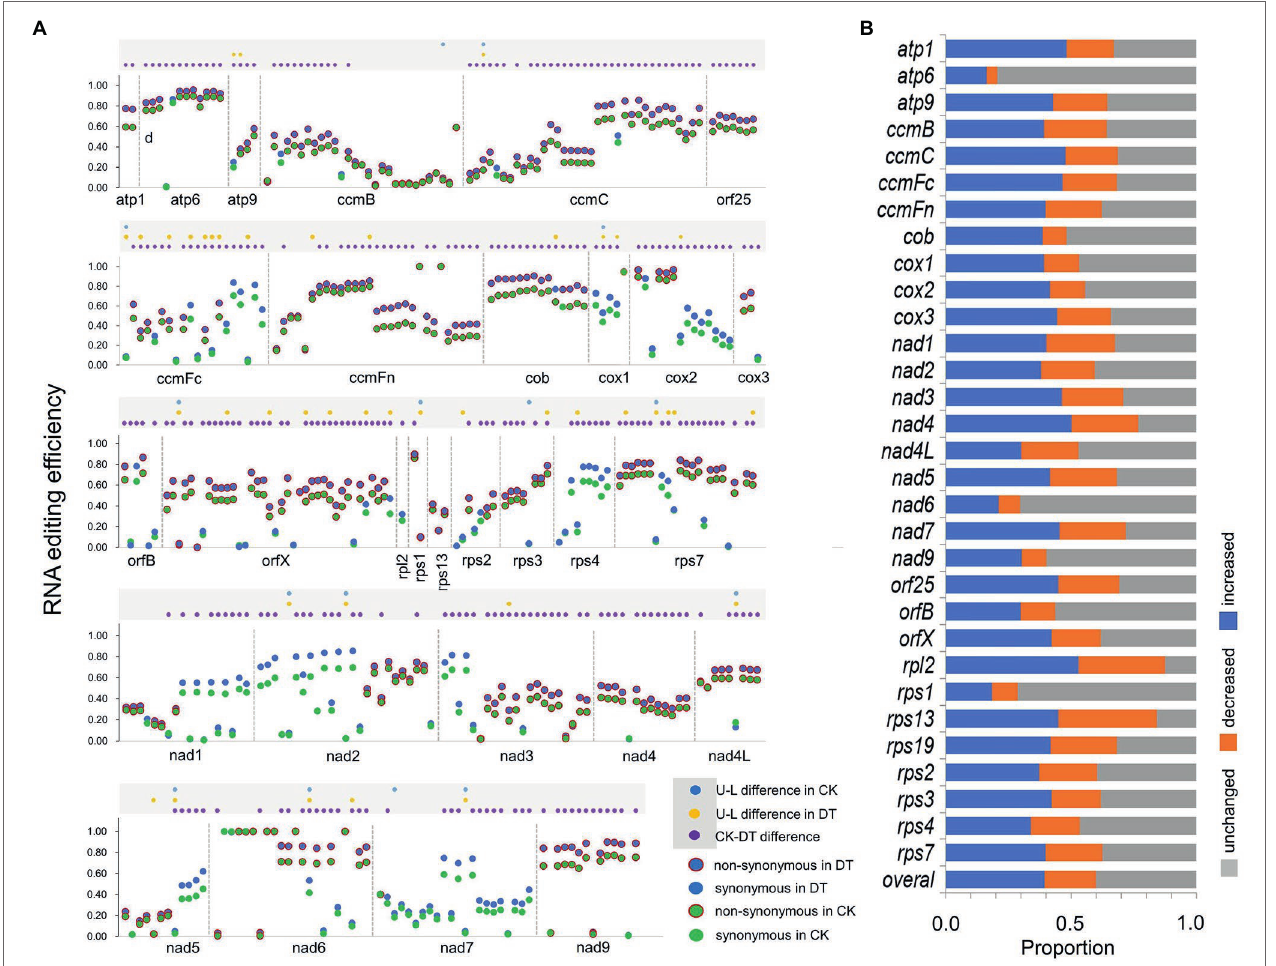
FIGURE 1 | Rice mitochondrial RNA editing in well-watered (CK) and drought-treated (DT) fields. (A) RNA editing efficiencies of upland (U) and lowland (L) rice at 426 informative sites in well-watered (CK) and drought-treated (DT) fields. The dots within gray rectangle on top mark the significant difference in editing efficiency between rice upland (U) lowland (L) or treatments. (B) Proportion of increased, decreased, and unchanged editing efficiencies of genotype-site combinations at each mitochondrial